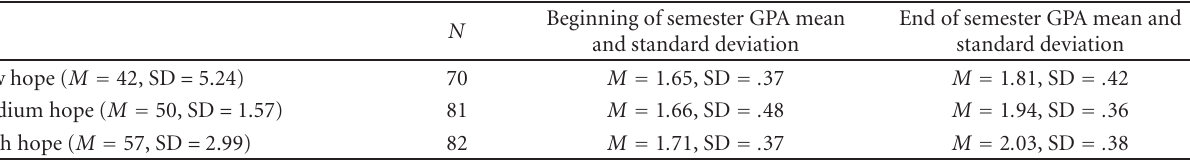
Table 1: Student hope and GPA levels prior to and after UNIV 01.